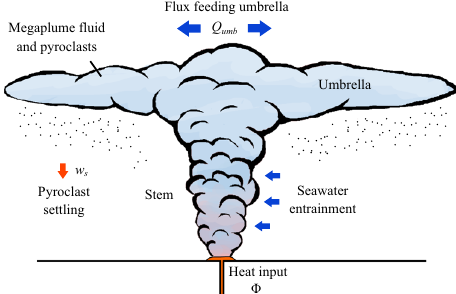
Fig. 3 Schematic showing the con fi guration and the processes controlling buoyancy-driven submarine tephra dispersal. The hydrothermal plume forms a turbulent convecting stem fed by lava heating and/or release of intracrustal fl uid, which accumulates and cools following entrainment of ambient seawater. The stem feeds the neutrally buoyant umbrella, which forms a primarily horizontally fl owing neutrally buoyant gravity current within the density strati fi cation of the ocean, with a volumetric fl ux of Q umb horizontal buoyancy-driven advection within the umbrella of a syn-eruptive hydrothermal plume. For an effectively quiescent ambient ocean, the umbrella of the plume will form an axisymmetric gravity current along a neutral level, advecting particles laterally by its own buoyancy-driven fl ow while maintaining the particles in suspension within turbulent eddies.